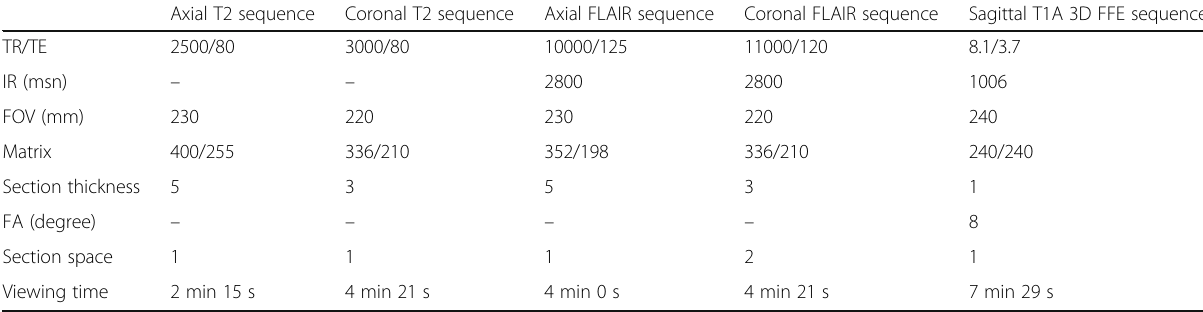
Table 2 Parameters used in 3-Tesla